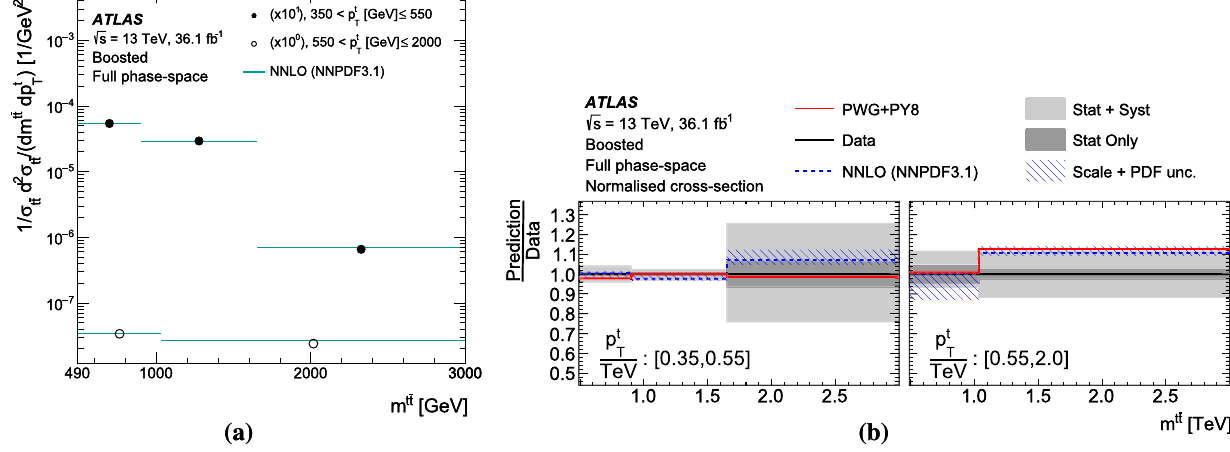
Fig. 67 a Parton-level normalised differential cross-section as a func- cross-section to the NNLO prediction and the prediction obtained with tion of m t ¯ t in bins of p t in the boosted topology compared with the the Powheg + Pythia8 MC generator. The hatched band represents the T NNLO prediction obtained using the NNPDF3.1 NNLO PDF set. Data total uncertainty in the NNLO prediction. The bands represent the sta- points are placed at the centre of each bin. b The ratio of the measured tistical and total uncertainty in the